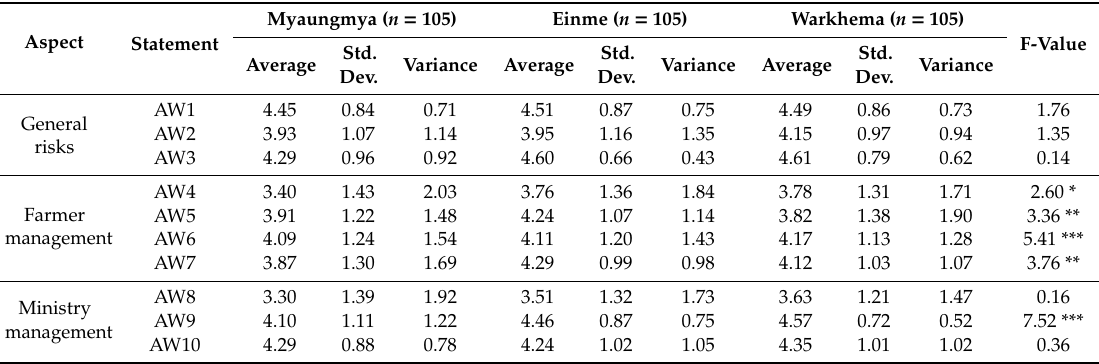
Table 8. Comparison of awareness statements among three